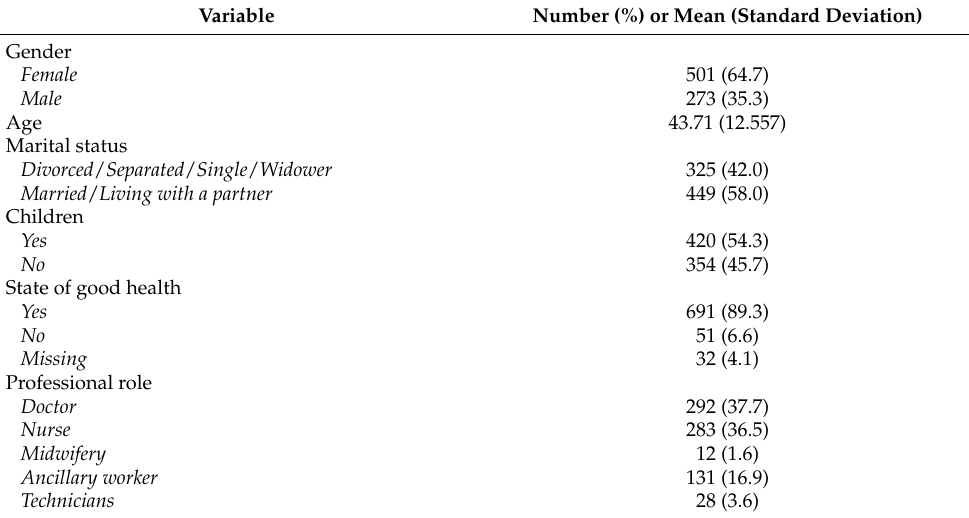
Table 1. Sample descriptive